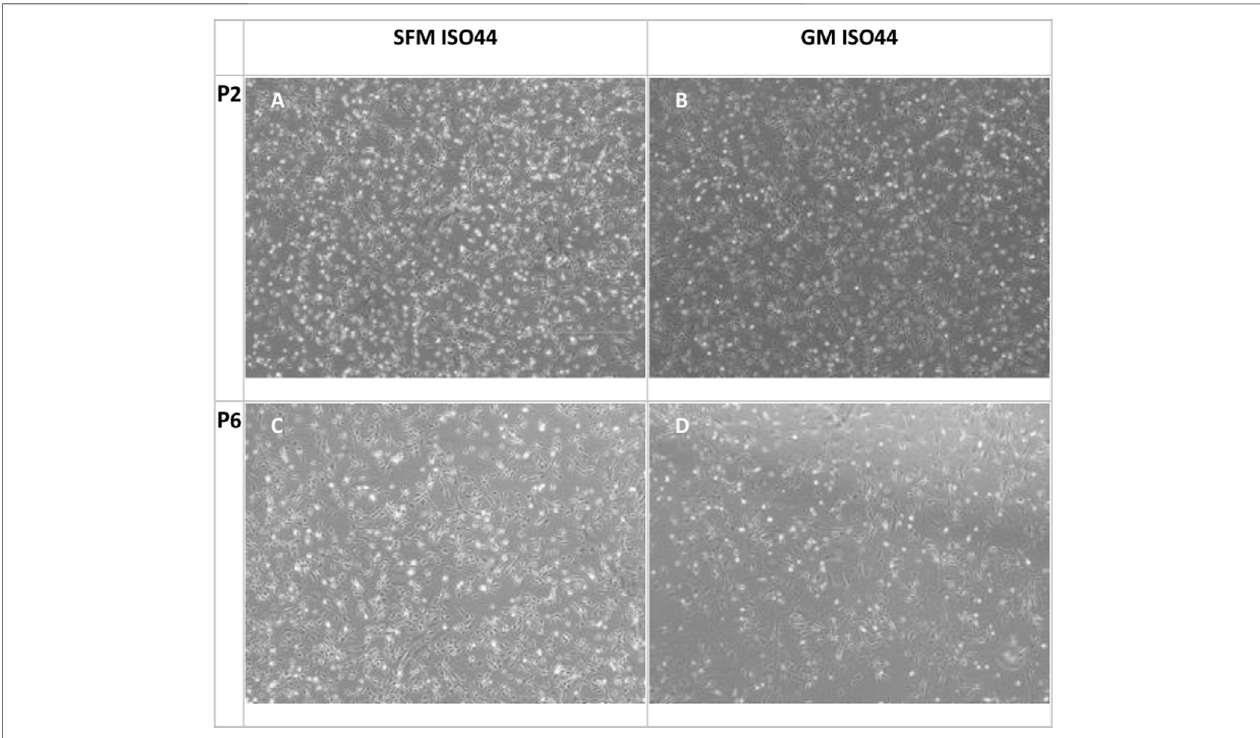
FIGURE7| Phasecontrastmicroscopyimagesofcellproliferationculturesatcon fl uenceforP2 (A,B) andP6 (C,D) withSFMandGM.Ingeneral,thecellsgrowing in SFM show a more rounded morphology compared to GM.